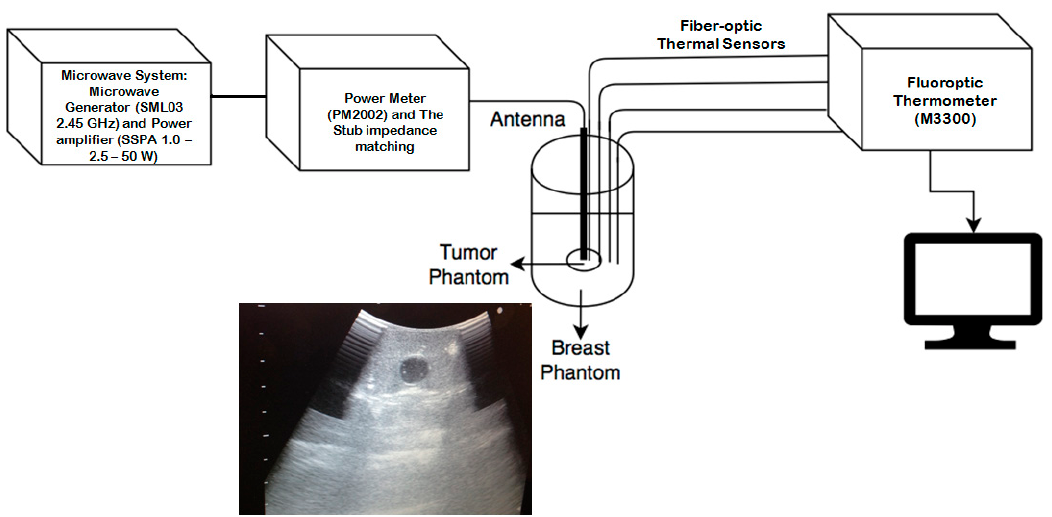
Figure 2. Phantom Experimental Setup. The radiation system supplied the microwave power to generate thermal ablation, while the non-interfering thermometry system measured the temperature increases inside the phantom every second during the